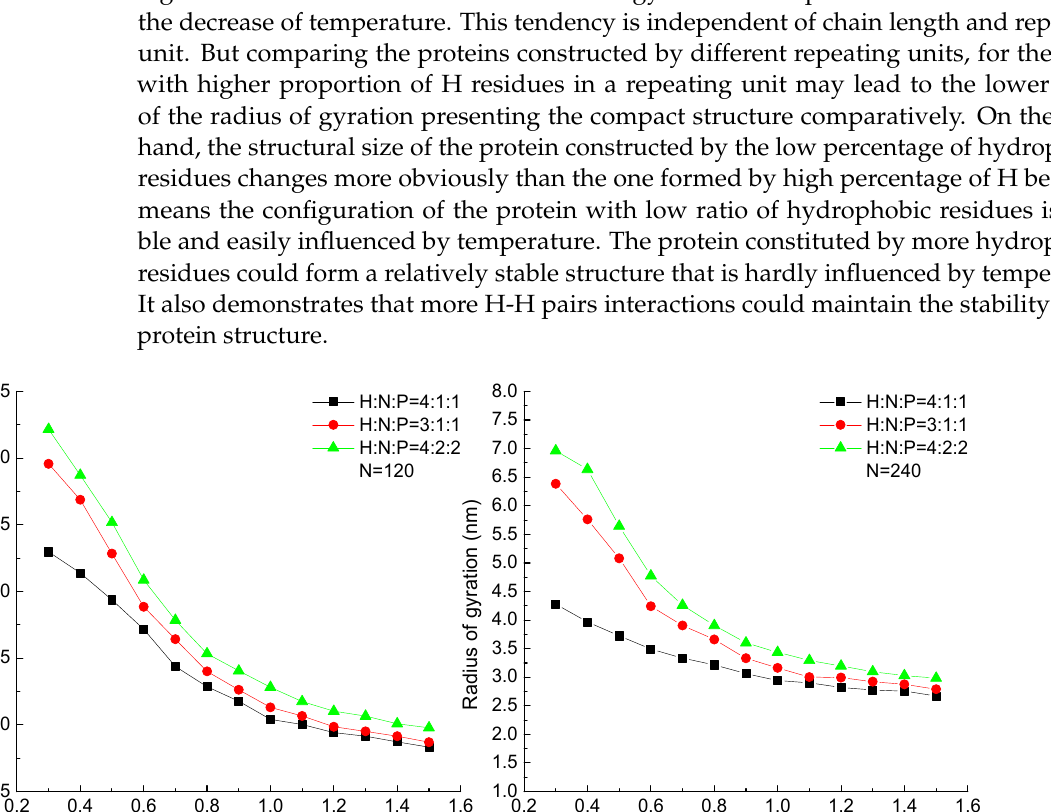
Figure 6. The global orientational order parameter P versus reduced temperature T * of H4N1P1, H3N1P1, and H4N2P2 with chain length of ( a ) N = 120, ( b ) N = 240 . By analyzing the non-bonded energy, the radius of gyration and the global orienta- tional order parameter of the protein, results show that the proteins with the same chain length but different HNP segment proportions in a repeating unit present the different size and orientational characteristics. The one with higher proportion of H residues re-